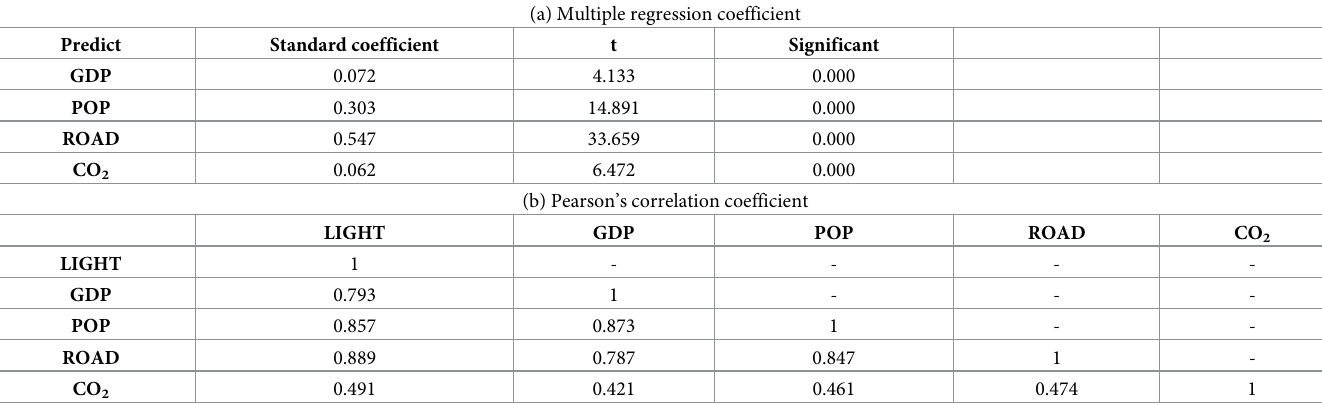
Table 11. Multiple regression coefficient and Pearson’s correlation coefficient of NTL density at county level in China.